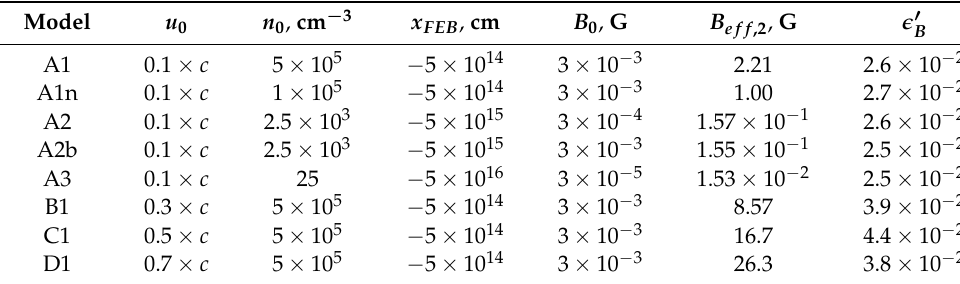
Table 1. The grid of Monte Carlo calculation